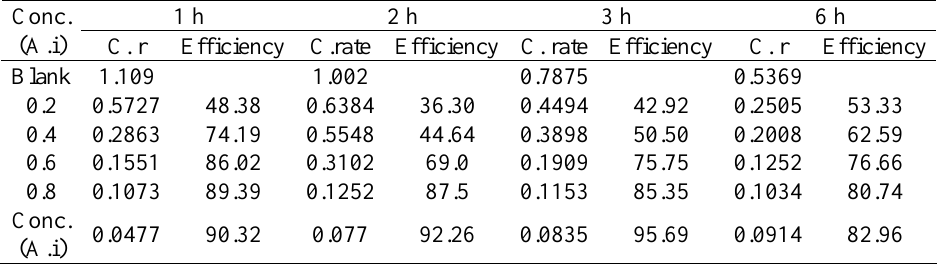
Table 2. Inhibitor efficiency and corrosion rate in HNO copper metal in 1 N HNO using Azadirachta indica seed extract 3